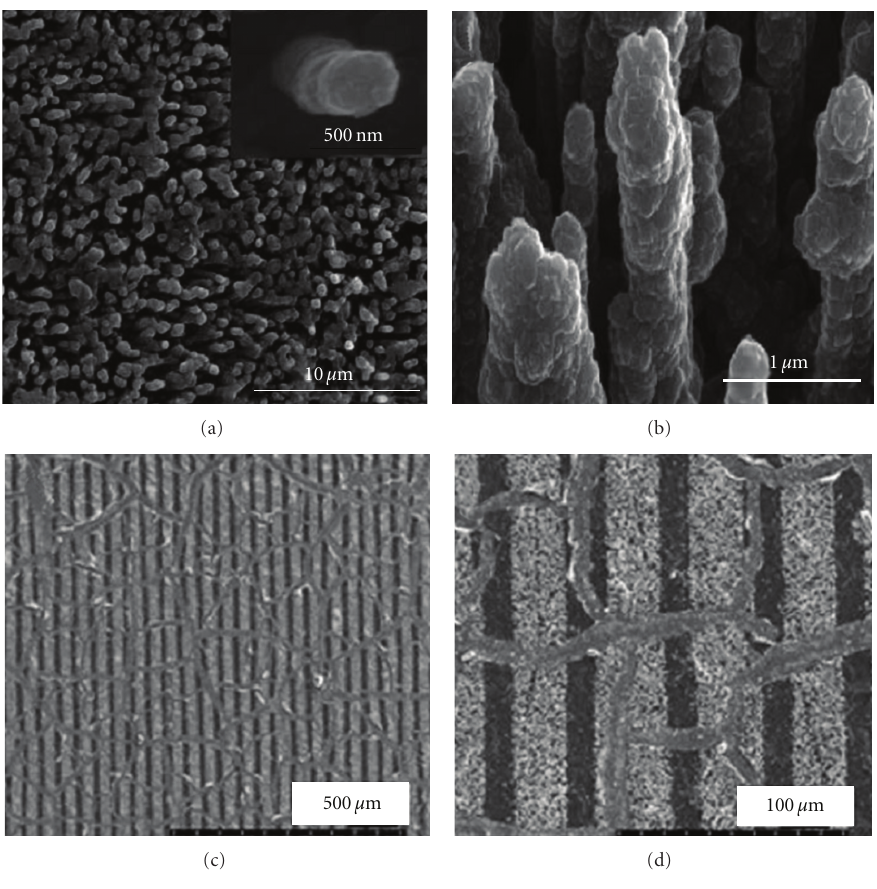
Figure 2: Images of BDD films with nanostructured surfaces: (a) and (b) BDD nanorod forest electrode image taken from di ff erent magnifications; (c) and (d) 2D micronetwork of boron-doped diamond film taken from di ff erent magnifications.